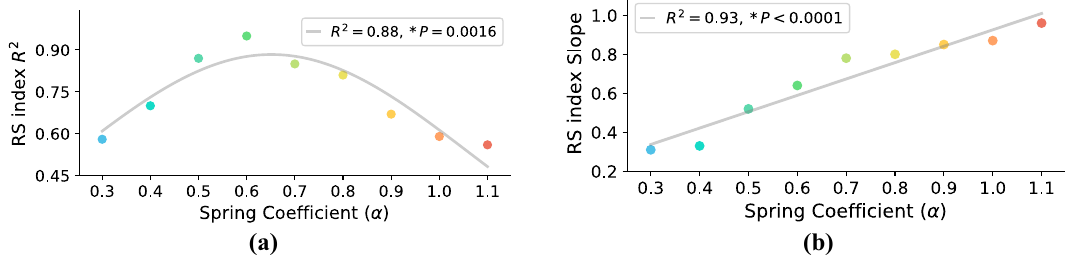
Figure 10. To check the linear relation between RS index and metabolic rate reduction in all spring coefficients, in this figure, we plot the R 2 (goodness of fit measure) and slope of this linear regression (gray line in Fig. 8e) for different spring coefficients. ( a ) Shows that the R 2 of linear regression, which is a quadratic diagram, and figure ( b ) indicates a linear relationship between the slope of linear regression and spring coefficients. It is worth mentioning that for the spring coefficients α < 0.3 and α > 1.1 , R 2 is very low; there is no linear relation for these ranges of α . ( b ) indicates that by increasing the spring coefficient, the variations of metabolic rate w.r.t. RS index increases; i.e., the sensitivity of the metabolic rate versus RS index